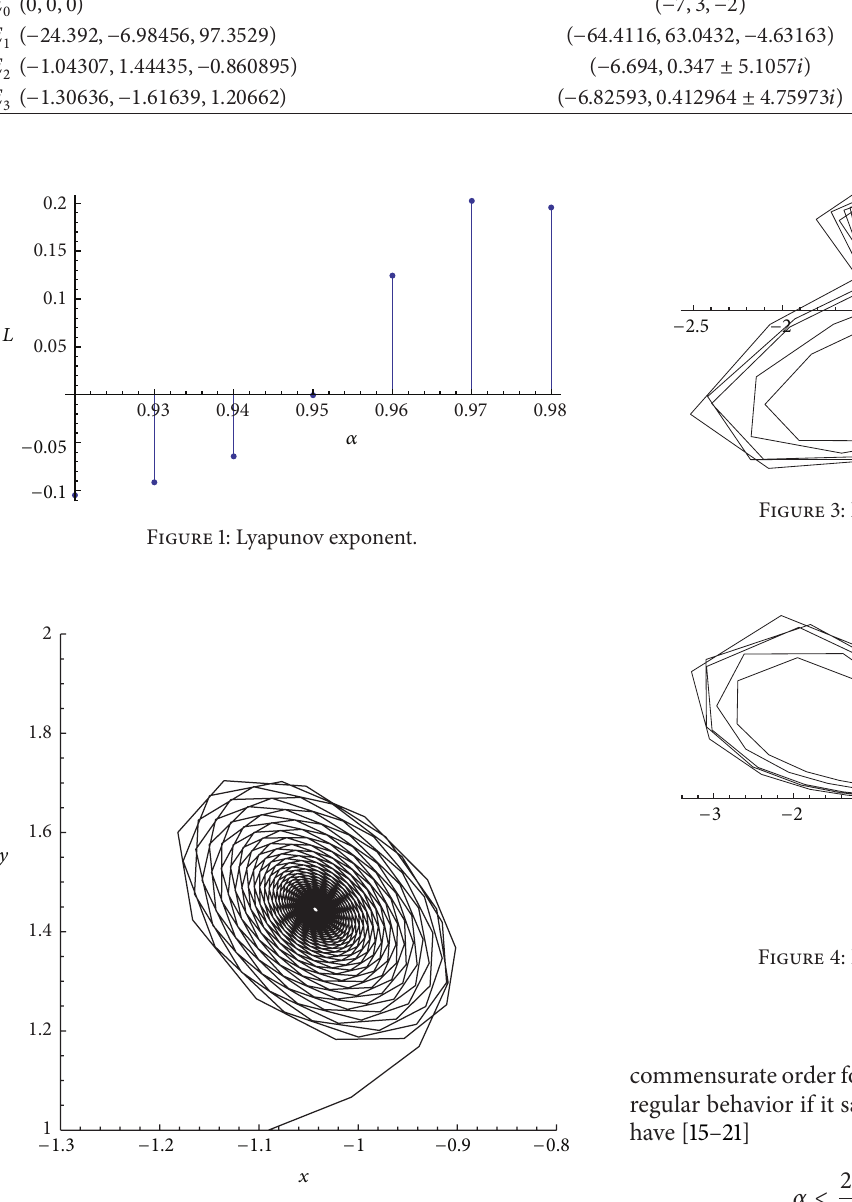
Figure 2: Phase portrait 𝛼 = 0.95 .